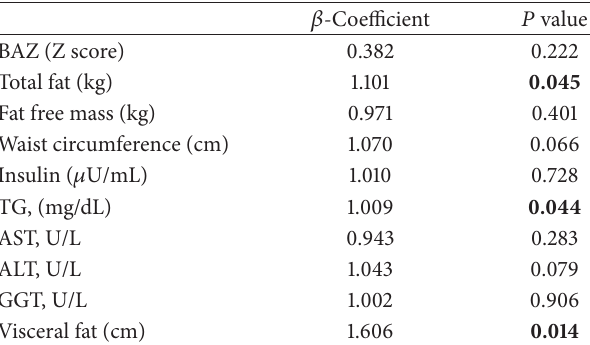
Table 4: Logistic regression analysis with NAFLD adolescents.